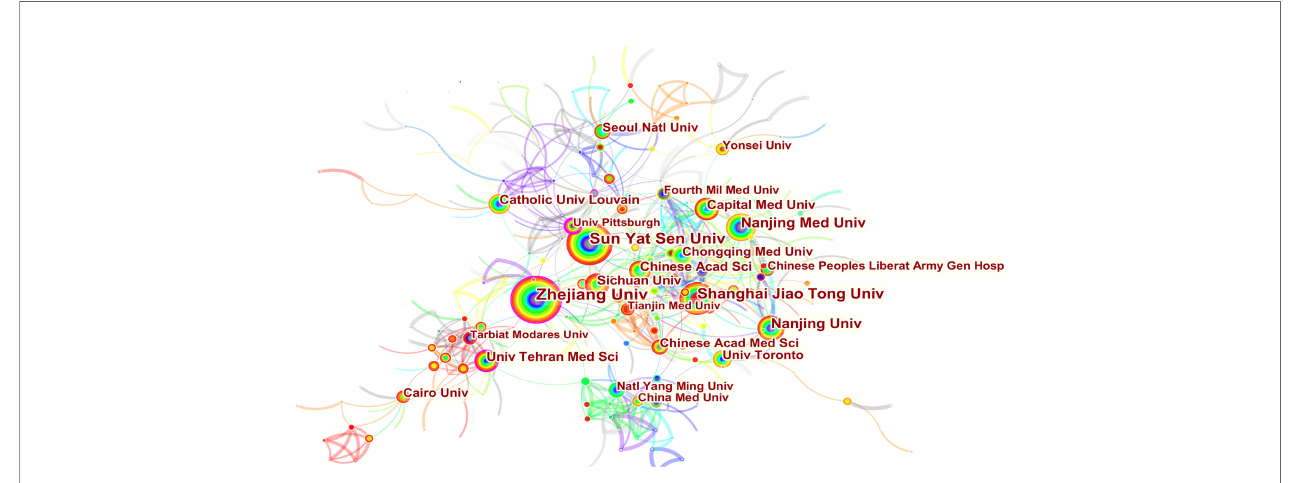
FIGURE 4 | Spatial distribution map